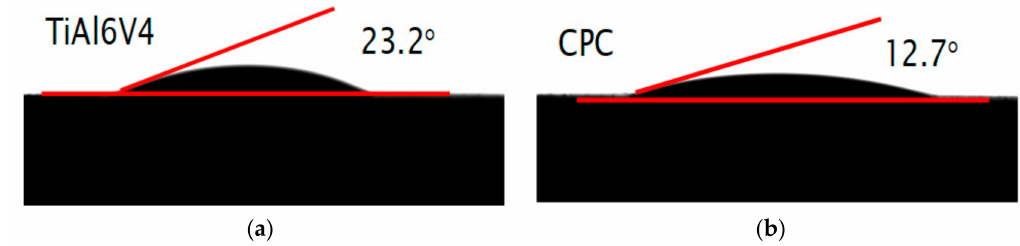
Figure 8. Contact angle measurements ( a ) on titanium alloy substrate; ( b ) on CPC coating